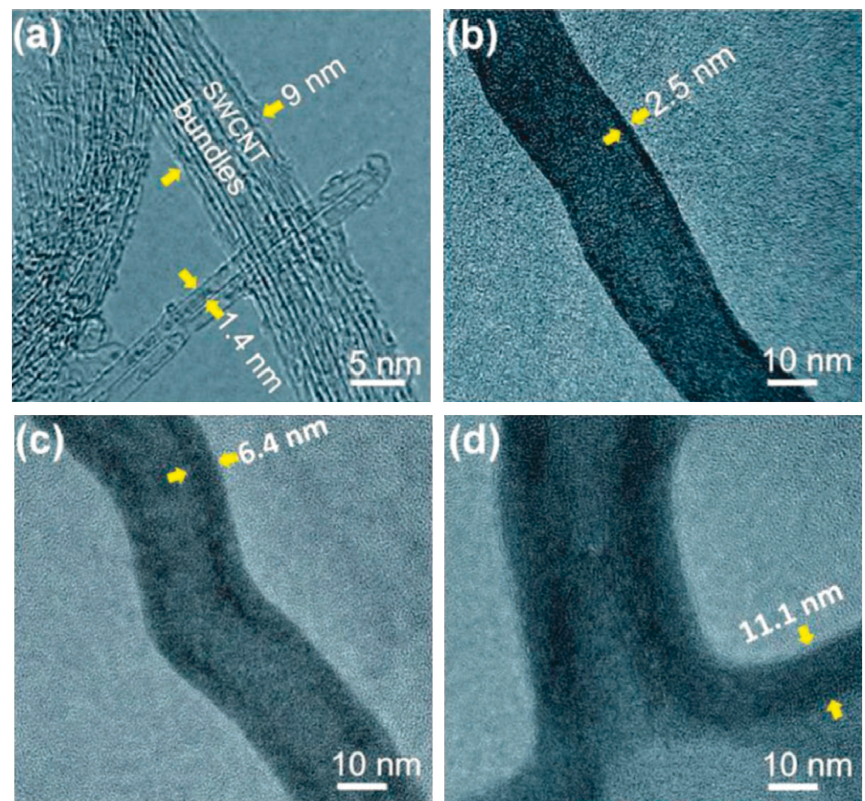
Figure 7: Transmission electron microscope images of carbon composites for application in electrochemical energy conversion [133,